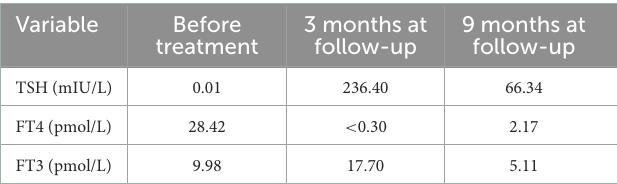
TABLE 1 Thyroid function before treatment and during follow-up.